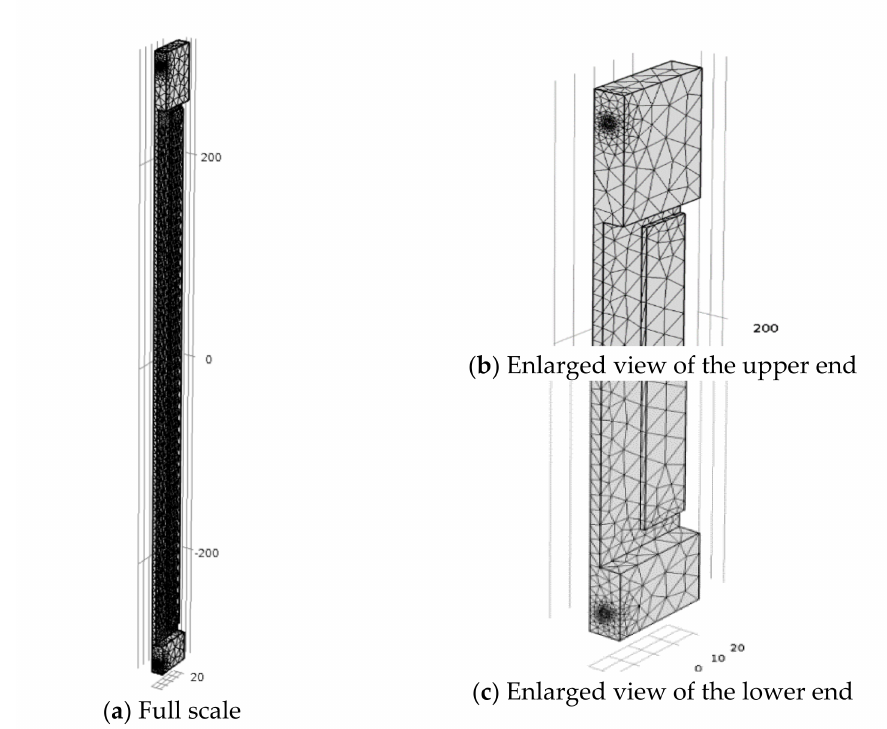
Figure 4. External meshes of the cold plate.